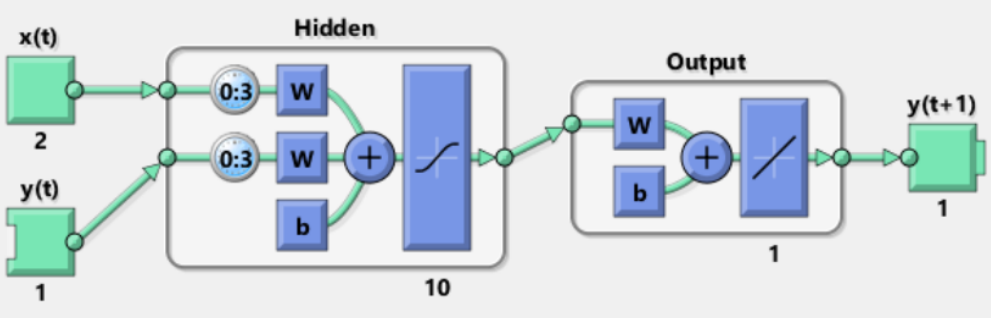
Figure 7. Integration of historical data and experts judgements in NARX, predict one step ahead.